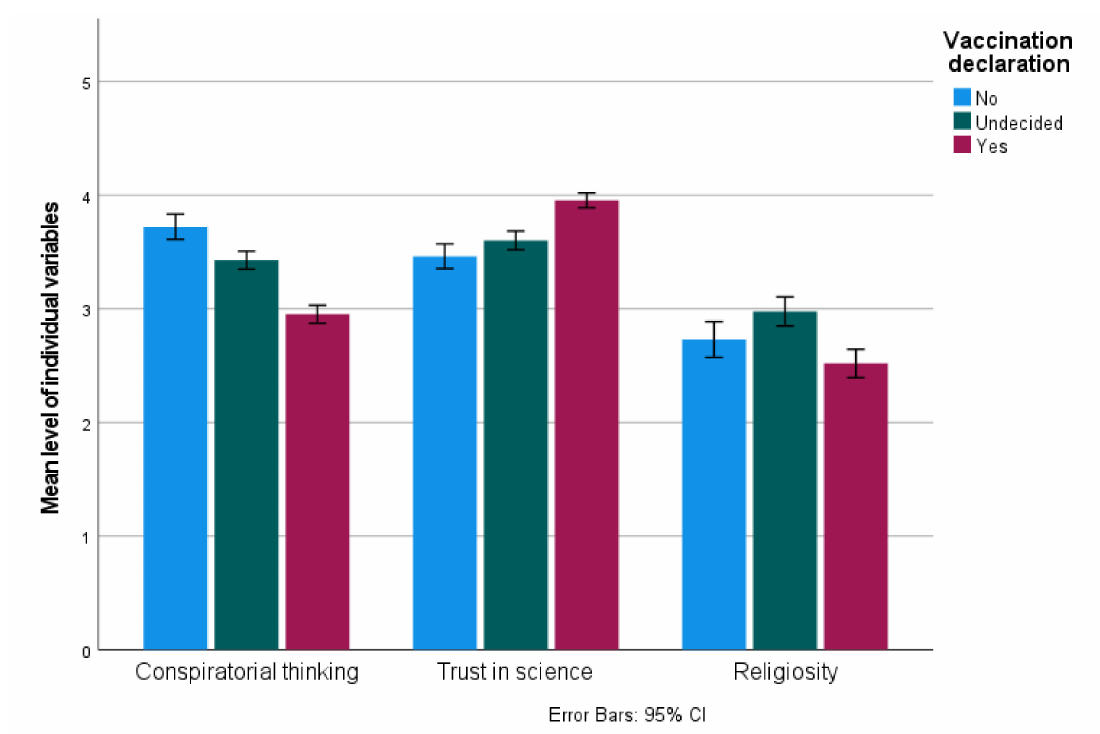
Figure 1. Individual differences and declared intention to vaccinate against